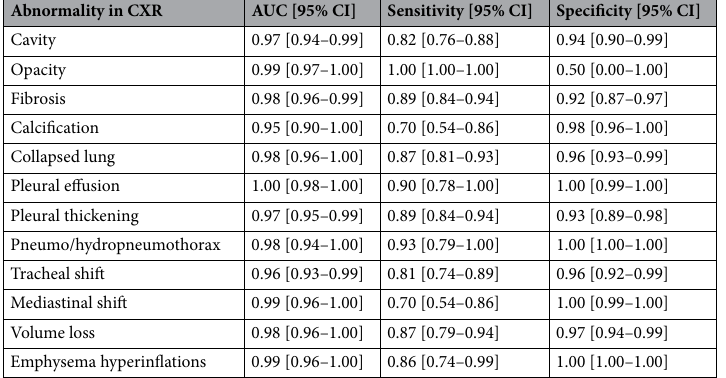
F1 score for bilateral lower zone Cavity and Calcification left lower zone were declared as undefined. Accuracy, precision and F1 score for external test set (supplementary Table S3) shows that accuracy ranges from 64 to 100%, 72% abnormalities scored accuracy > 90% with nearly 30% (n = 14) abnormalities spotted with 100% accuracy. Due to the lack of true positive data points, many abnormalities were declared undefined in precision and F1 score. ROC curve for lung zone wise and lung wise abnormalities for intramural test set (Fig. 2) and external test set are also shown(Fig. 3).